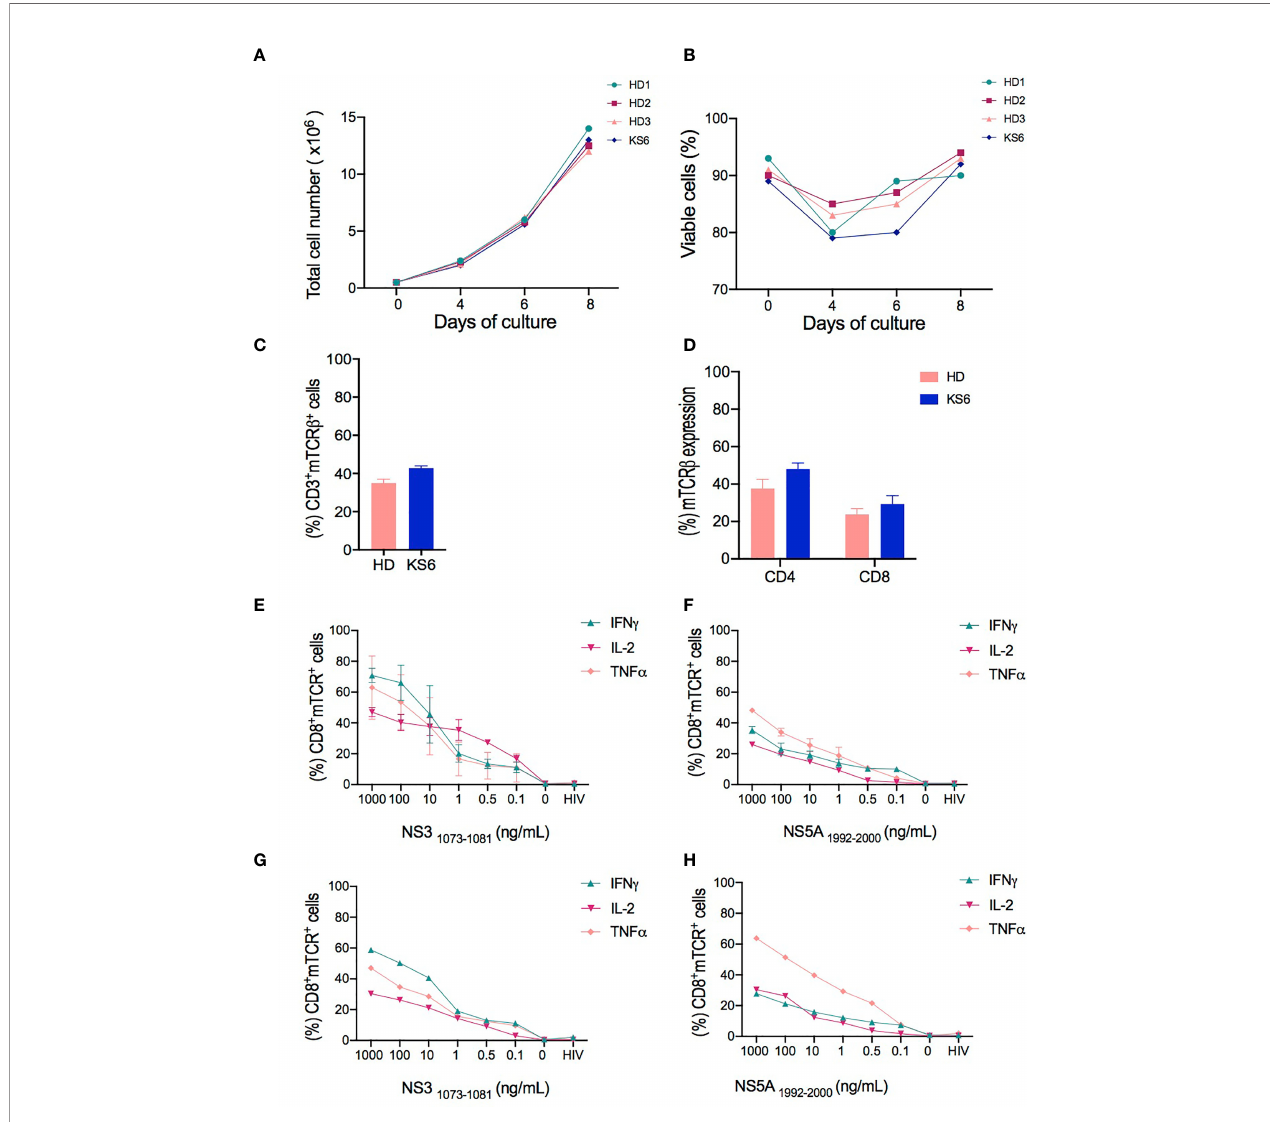
FIGURE 2 | Characterization of T cell receptor (TCR)-T cells produced in small-scale experiments. (A, B) Comparison of the total cell number and viability of cell products from healthy donors (HD1-3) and chronically hepatitis C virus (HCV)-infected patient (KS6) performed on days 0, 4, 7, and 8 of cell expansion. (C) Transduction ef fi ciency of redirected TCR-T cells represented by the percentage of mTCR expression in CD3+ cells from healthy donors and HCV-infected patient (KS6) after 8 days of expansion. (D) Percentage frequencies of mTCR expression in CD4+ and CD8+ T cells following T cell expansion. HCV-speci fi c responses assessed by fl ow cytometry analysis for the intracellular content of IFN g , TNF a , and IL-2 in CD8+ transduced cells following 6 h of coculture of NS3 1073 – 1081 or NS5 1992 – 2000 peptide-loaded T2 cells with redirected TCR-T cells from healthy donors (E, F) and chronically HCV-infected patient (G, H) . HIV peptide-loaded T2 cells and non-stimulated T cells were included as negative controls in the coculture experiments performed in triplicate